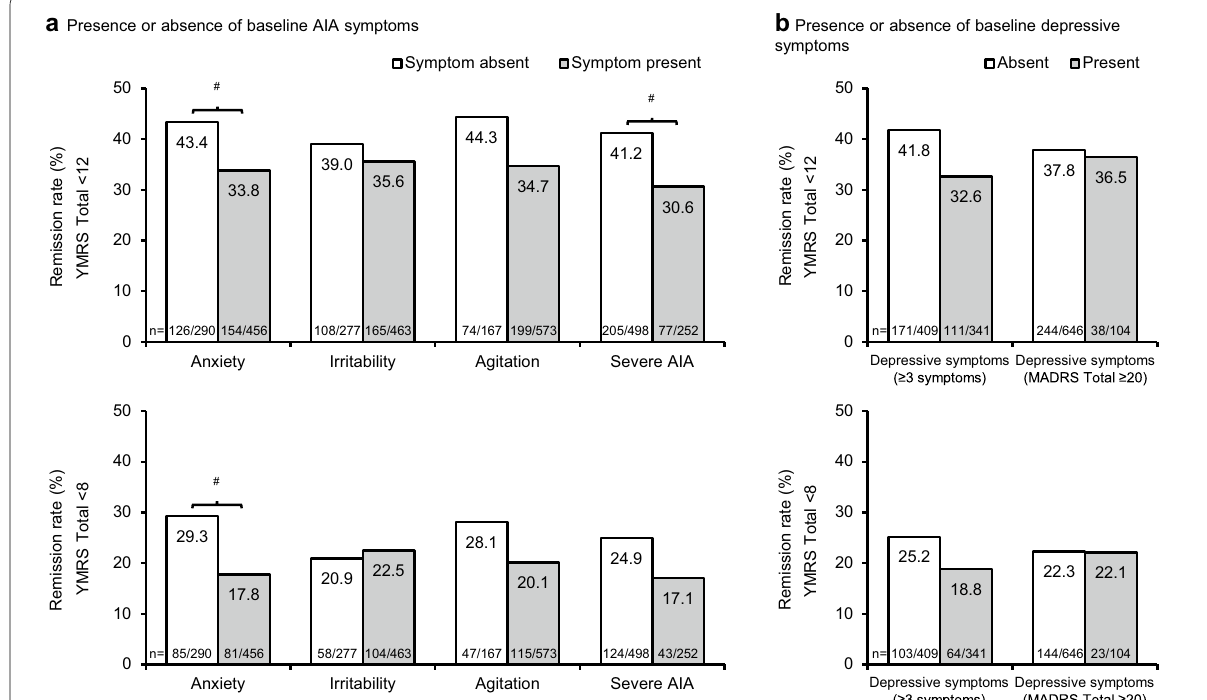
Fig. 3 Incidence of remission in BD-I mania, stratified by baseline AIA/depressive symptoms. # p -value significant (when adjusted for multiplicity), Chi squared test. Anxiety was defined as a PANSS anxiety item score of at baseline. Agitation was defined as a YMRS increased motor activity–energy item score of above criteria for all three AIA symptoms. Patients missing a value for the corresponding symptom at baseline were not included in the analysis. Two definitions were used for remission: a YMRS Total score of <12 at Day 21 (upper figures); and a YMRS Total score of <8 at Day 21 (lower figures) (observed cases). Depressive symptoms were defined in two ways: at baseline. AIA, anxiety, irritability, and agitation; BD-I, bipolar I disorder; MADRS, Montgomery–Åsberg Depression Rating Scale; PANSS, Positive and Negative Syndrome Scale; YMRS, Young Mania Rating Scale. a Presence or absence of baseline AIA symptoms and b presence or absence of baseline depressive